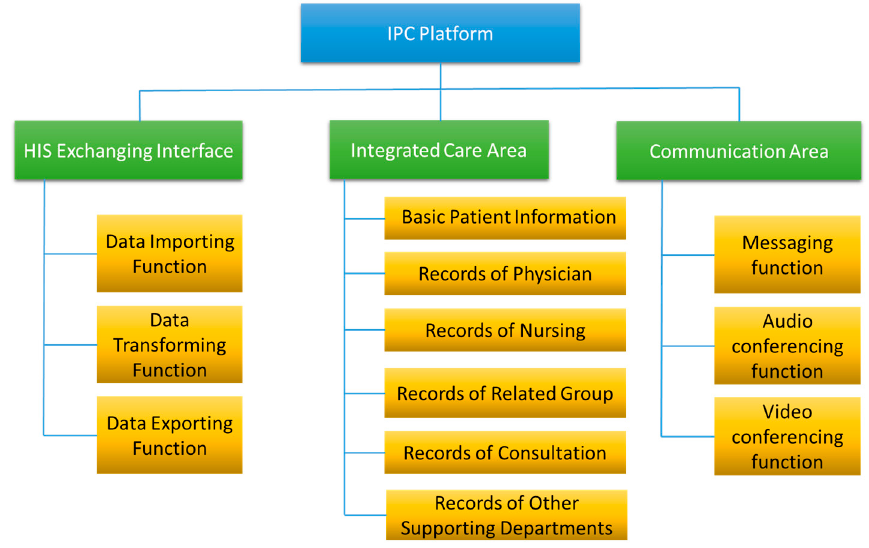
Figure 3. Functional architecture of the IPC platform.